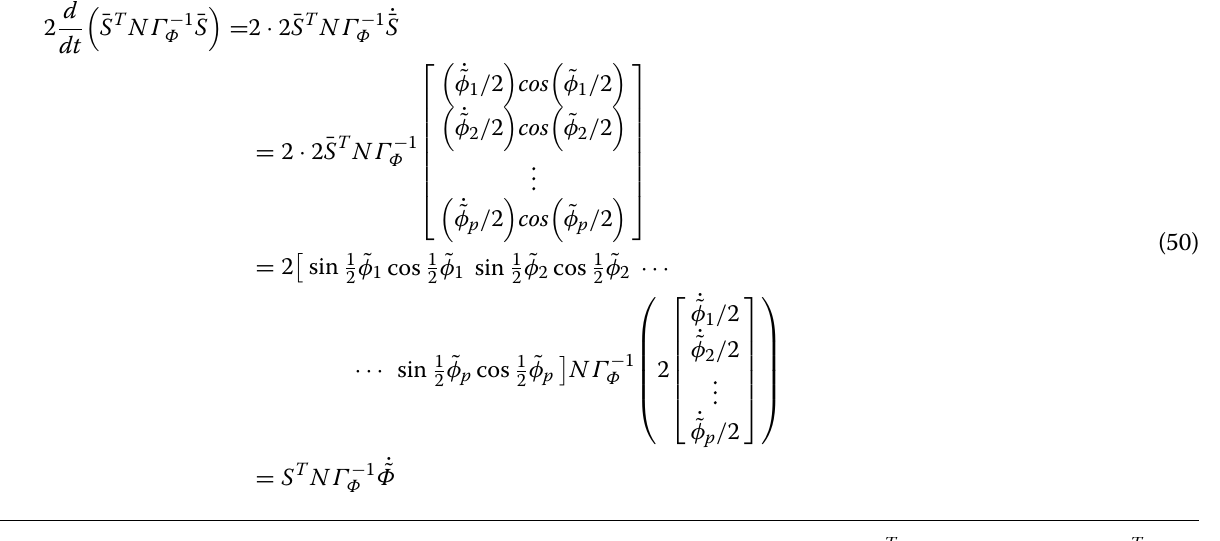
In the variation of the bottom expression, we used the well-known trigonometric formula 2 sin θ cos θ = sin 2 θ .